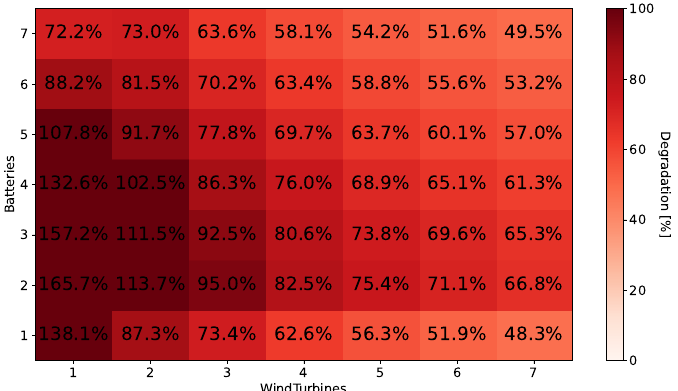
Figure 24. Degradation of the batteries over 20 years of usage with strategy